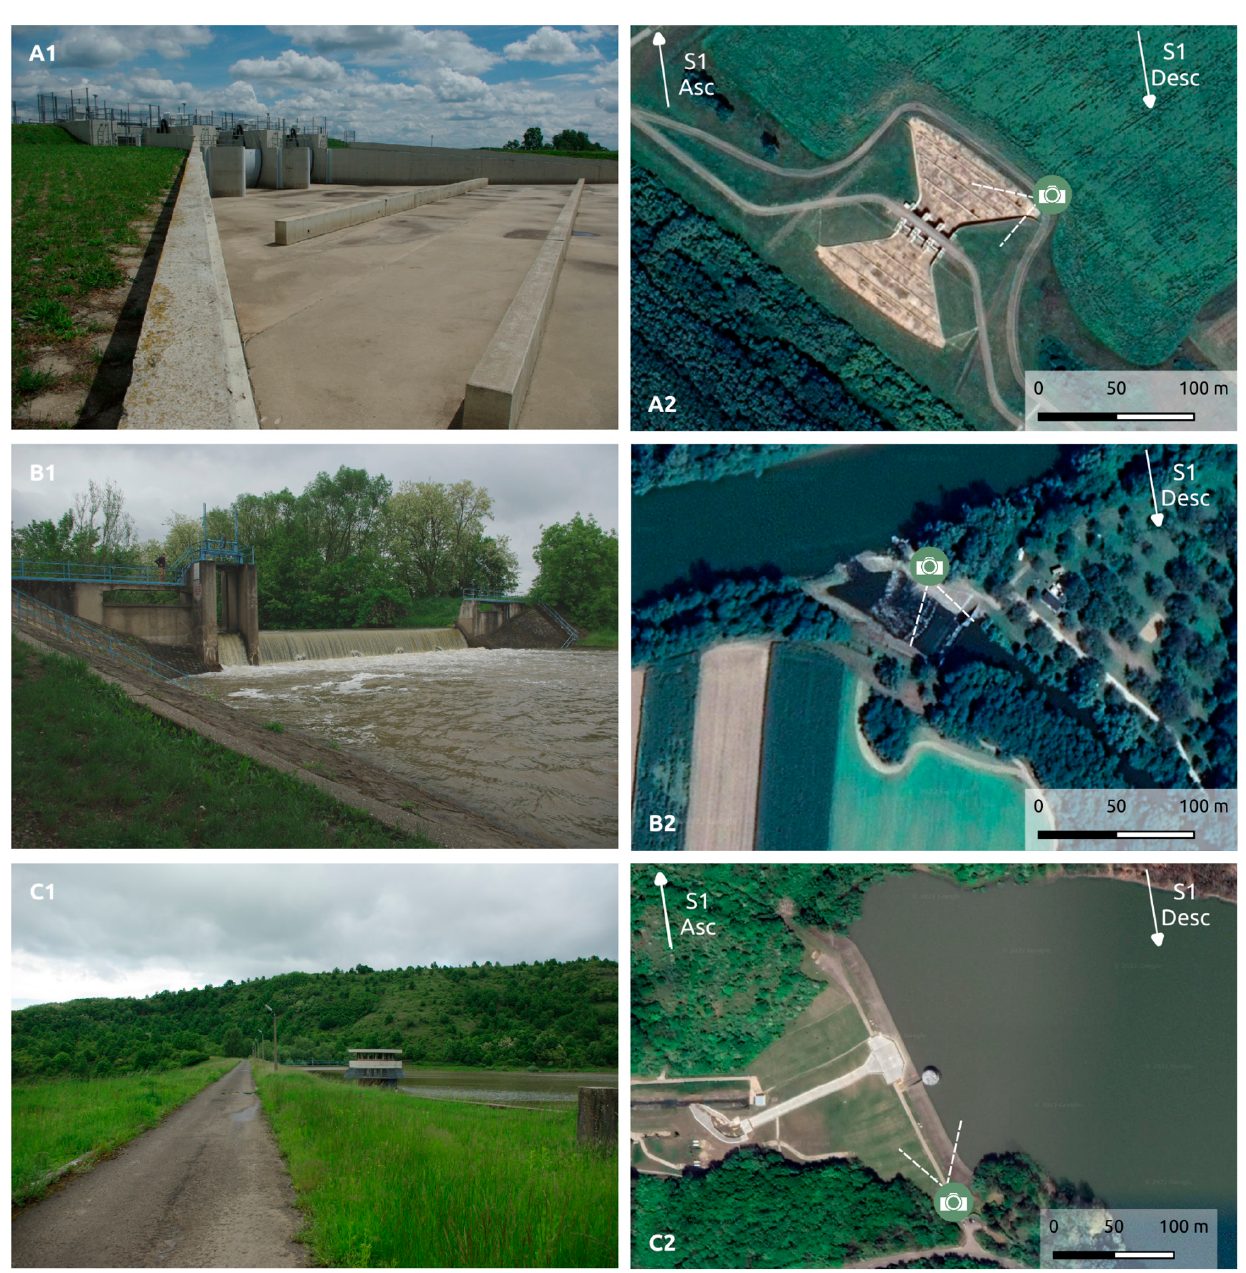
Figure 5. Typical detectable ( A1 ), undetectable ( B1 ) and improvable ( C1 ) sites and their land cover from Google satellite images ( A2 – C2 ). Typical PS densities of site types are the following: undetectable site = 0 PS (but improvement is impossible with CR), detectable = usually 5 + PS, improvable = from 0 to 5 (but improvement is possible with CR).